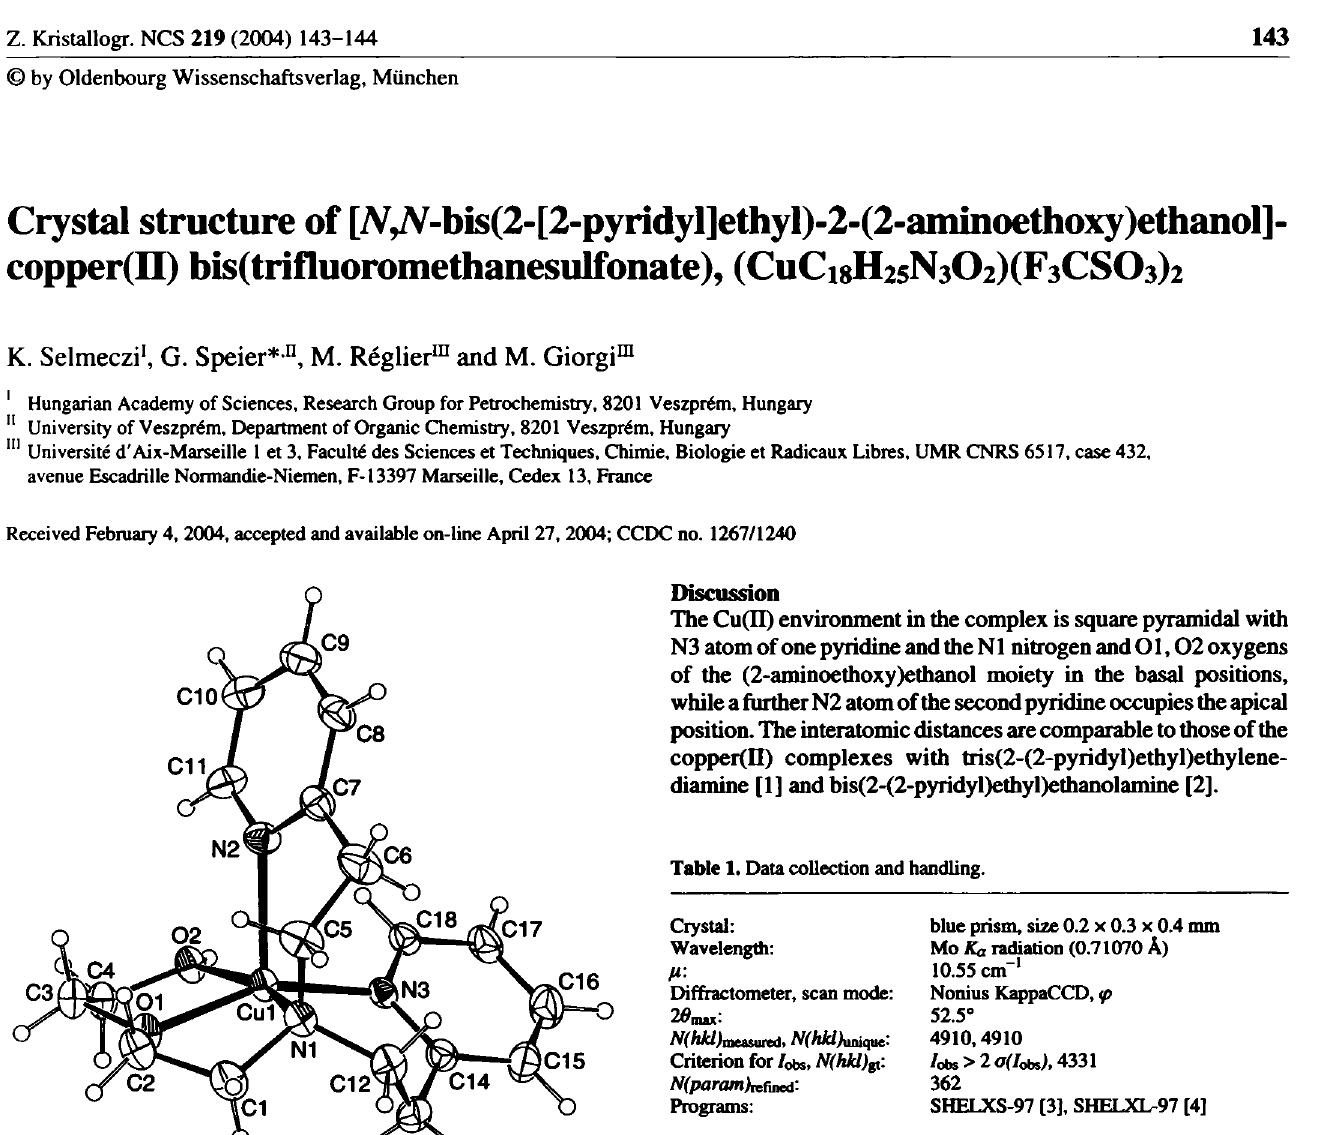
Table 2. Atomic coordinates and displacement parameters (in Â 2